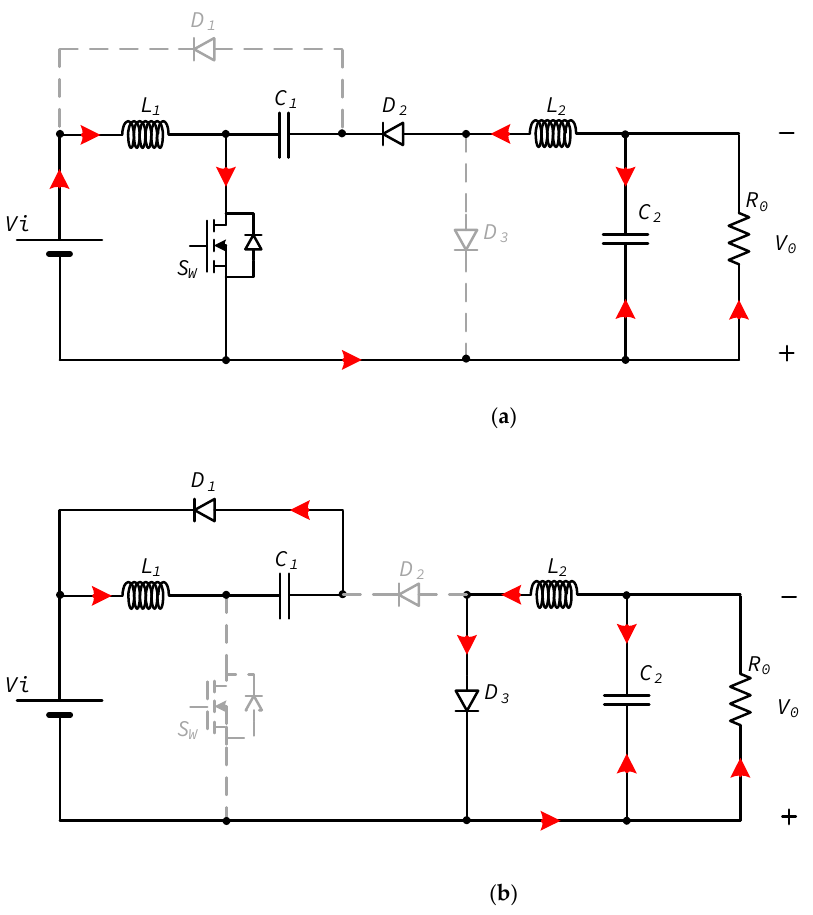
Figure 3. Converter operation modes. ( a ) Mode 1 — S w is ON. ( b ) Mode 2 — S w is OFF. Operation mode 1, S w is driven ON : during the time interval from 0 to δ T s , the switch S w is in the ON state, and diode D 2 is in the ON state, whereas diodes D 1 and D 3 are reverse-biased. The stored energy in L 1 and L 2 inductors will increase while capacitor C 1 is discharging. Consequently, the L 1 inductor current will increase and the capacitor voltage C 1 will decrease. The diode D 1 is reverse-biased as it has a negative voltage